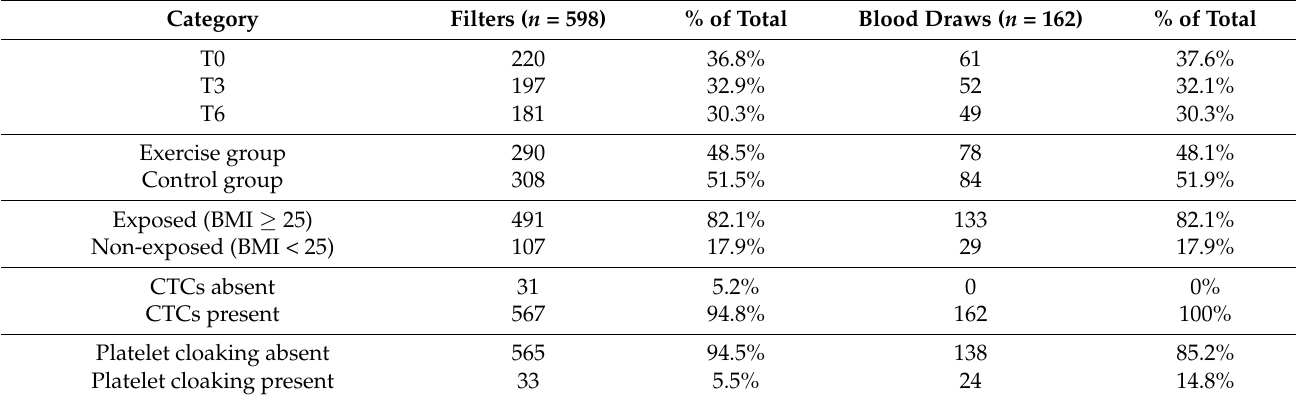
Table 1. Categorisation of ScreenCell filters and blood draw episodes.